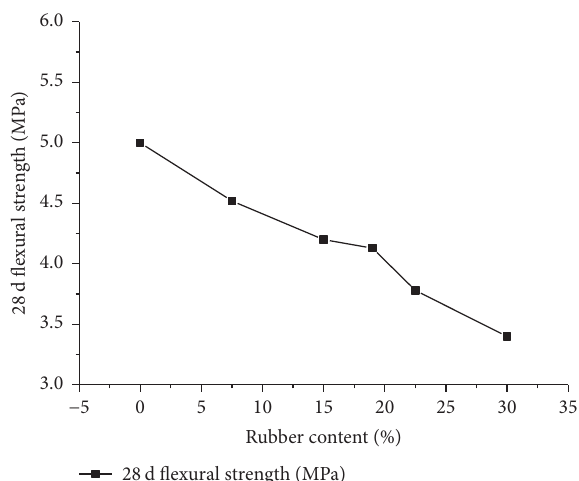
Figure 3: 28 d the ratio of compressive to flexural strength with different amount of 60-mesh rubber particles.